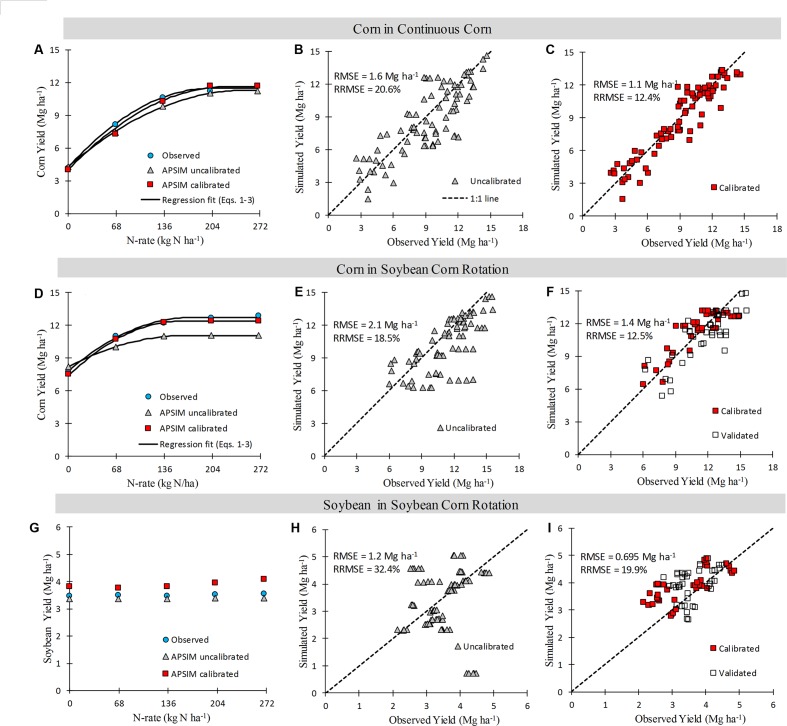
Sixteen year mean crop yield response to N fertilizer rate (A, D, and G panels), and observed versus simulated crop yields across years and N rate (B, C, E, F, H, and I). Points are observations or simulations, continuous lines are regression fits from Eqs. 1–3, and broken lines show 1:1 relationship.